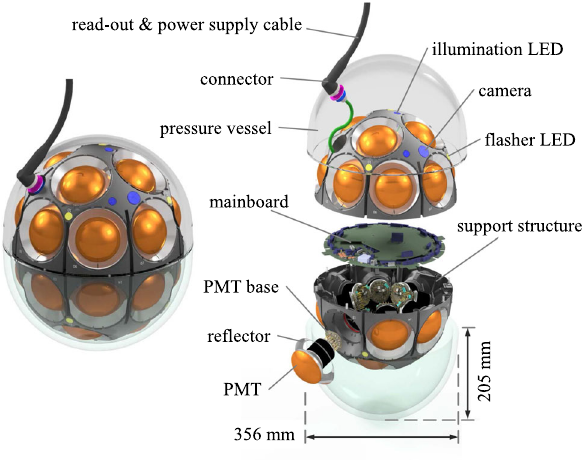
Fig. 1 Left: rendered picture of a mDOM. Right: exploded view with labeling of the main components